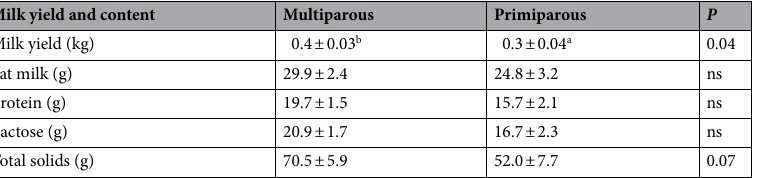
Table 4. Milk composition and milk yield (LS mean ± sem) at 91 days postpartum in multiparous (n = 19) or primiparous (n = 12) ewes. ns not significative ( P >